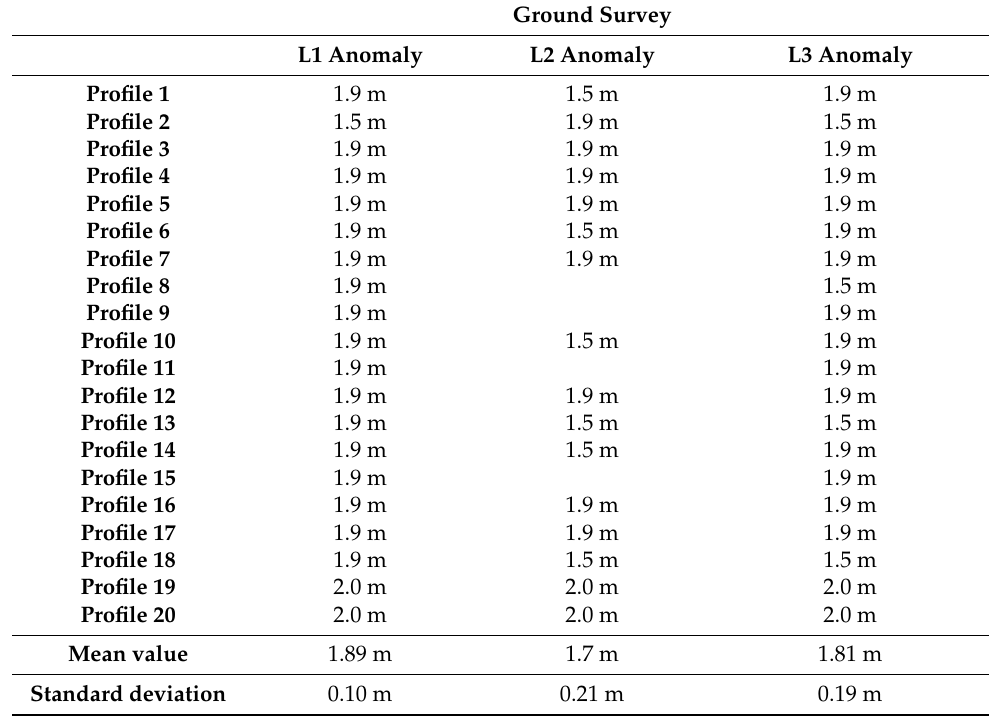
Table 2. Estimated depths along the profiles of the ground